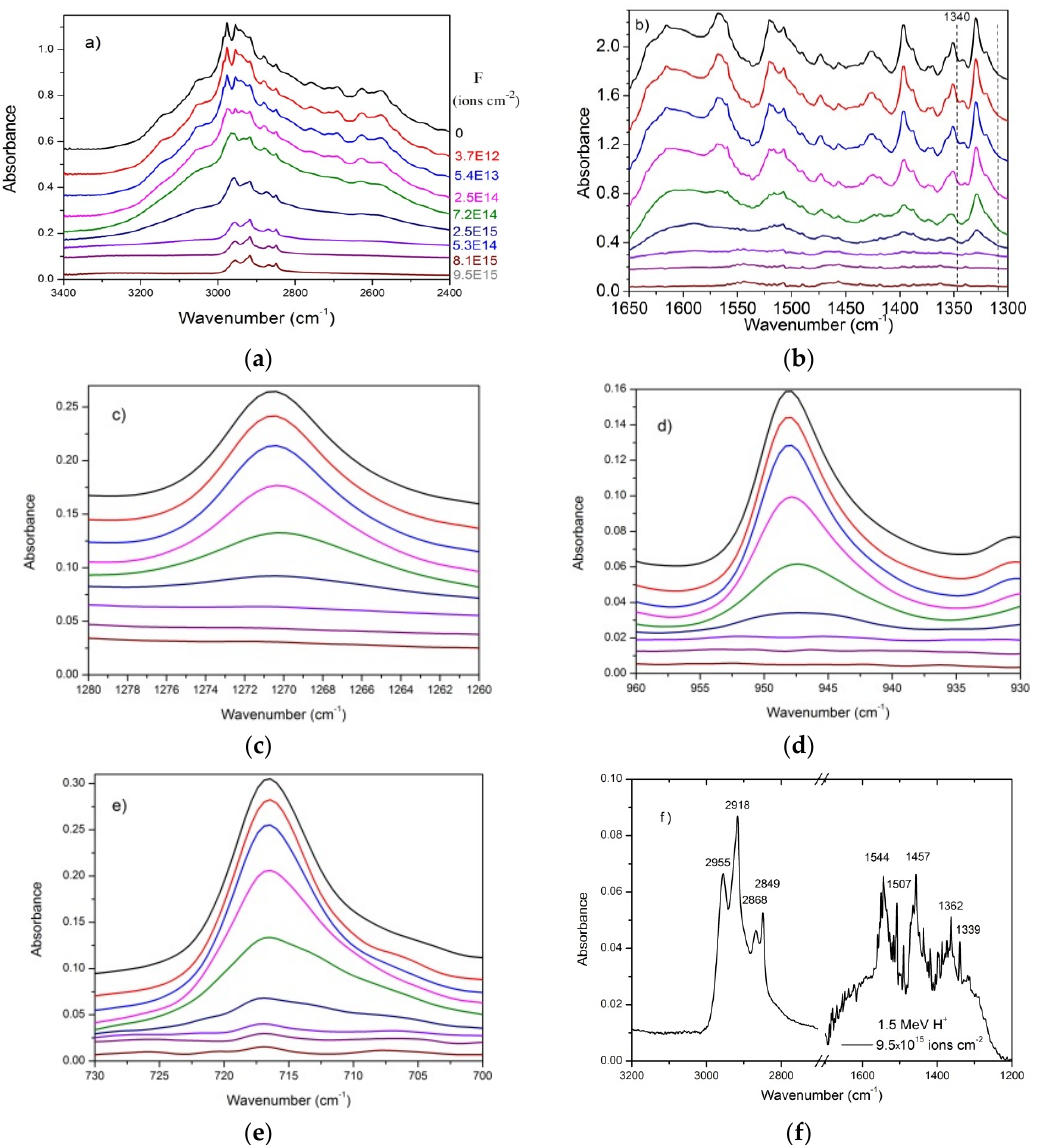
Figure 2. Decrease of valine absorbance as the 1.5 MeV H + beam fluence increases for five selected IR regions ( a – e ). Note in particular that absorbances of 1329, 1271 and 948 cm − 1 bands disappear completely, while those of 2955, 1507 and 716 cm − 1 bands do not. The fluence legend for Figure 2a is the same for all figures. Panel ( f ) is a zoom of ( a ) and ( b ), for the highest fluence. − 1 The fact that the 1544 and 1457 cm features increase along the irradiation (dominating the IR spectrum at the end) indicates that they are not valine bands; instead, they belong to valine daughter − 1 − 1 molecules. Furthermore, the 3300–2400 and the 1500–1300 cm spectral regions, as well as the 716 cm band, present a slower decrease rate and do not disappear at the final fluence; they should be formed by two overlapping components, one due to precursor molecule bands, the other due to product bands. Table 1 presents the wavenumber of the main observed valine bands. Here, the third column displays + the wavenumber of products after H